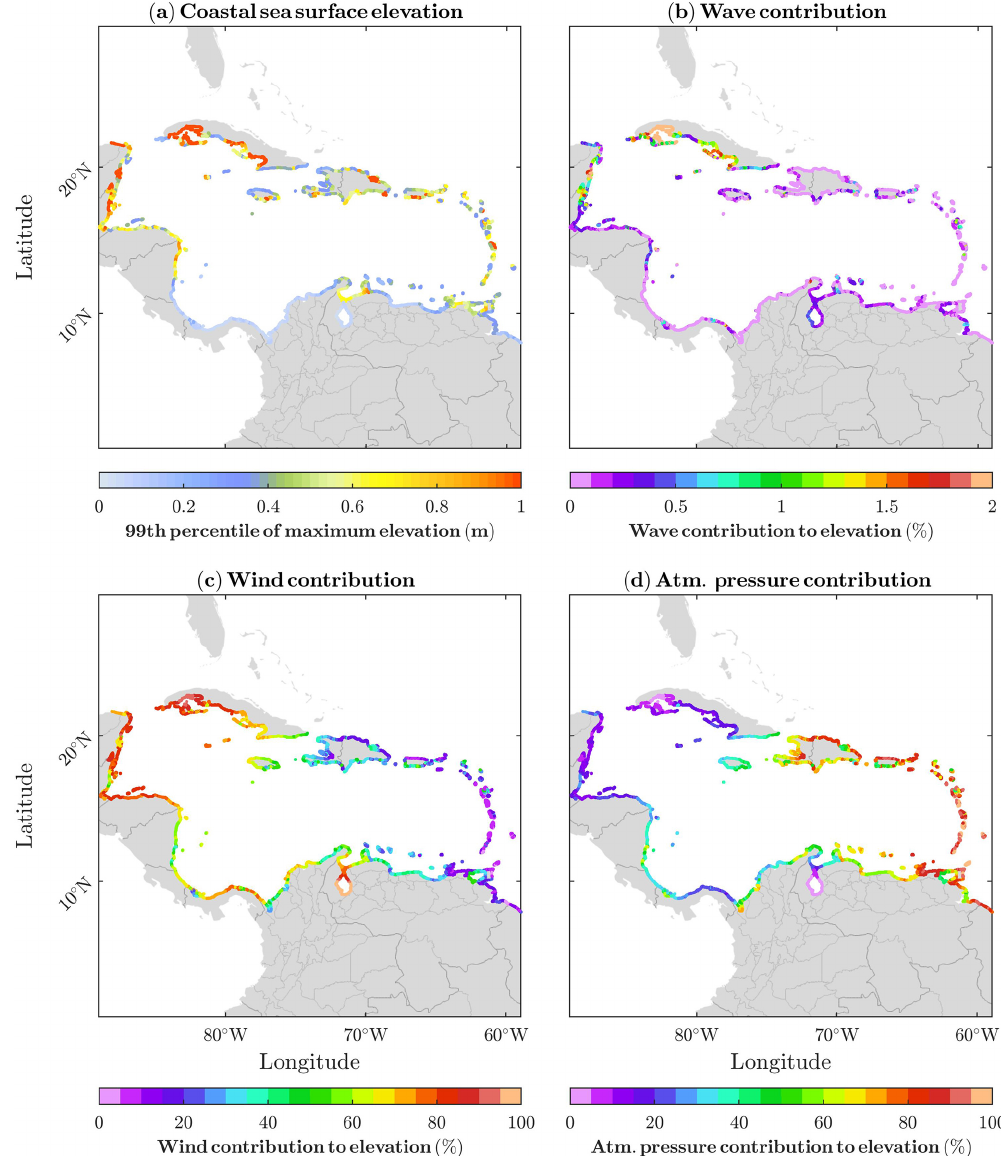
Figure 6. The 99th percentile of the maximum sea surface elevation (a value that corresponds to the 10th most intense TC at each grid point) along the Caribbean coast (a) and its contributions: wave setup (b) , wind (c) and atmospheric pressure (d) in absolute terms. All panels were calculated using the nearest point to coast at a depth of 20m to avoid problems with relatively coarse shore